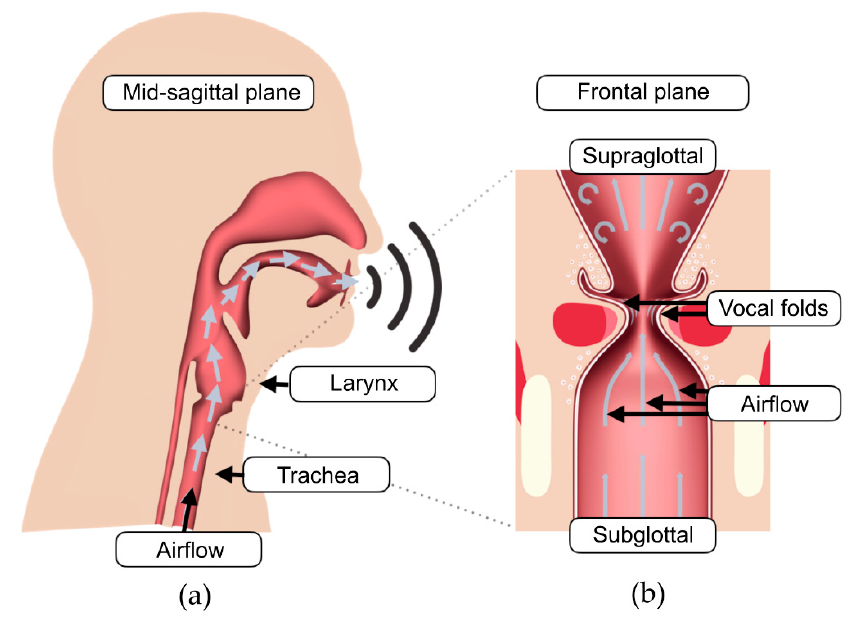
Figure 1. ( a ) Simplified way of air for voice production in overview; ( b ) Schematic longitudinal section through the larynx with laminar airflow under and turbulent airflow above the vocal folds.